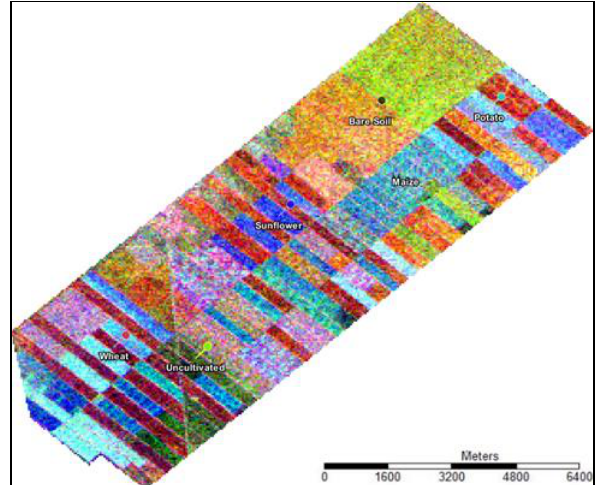
Figure 5. RGB color composite using multi-temporal Sentinel-1 SAR data in descending pass direction (R: 2016.05.15_VH_dB, G: 2016.06.01_VV_dB, B: